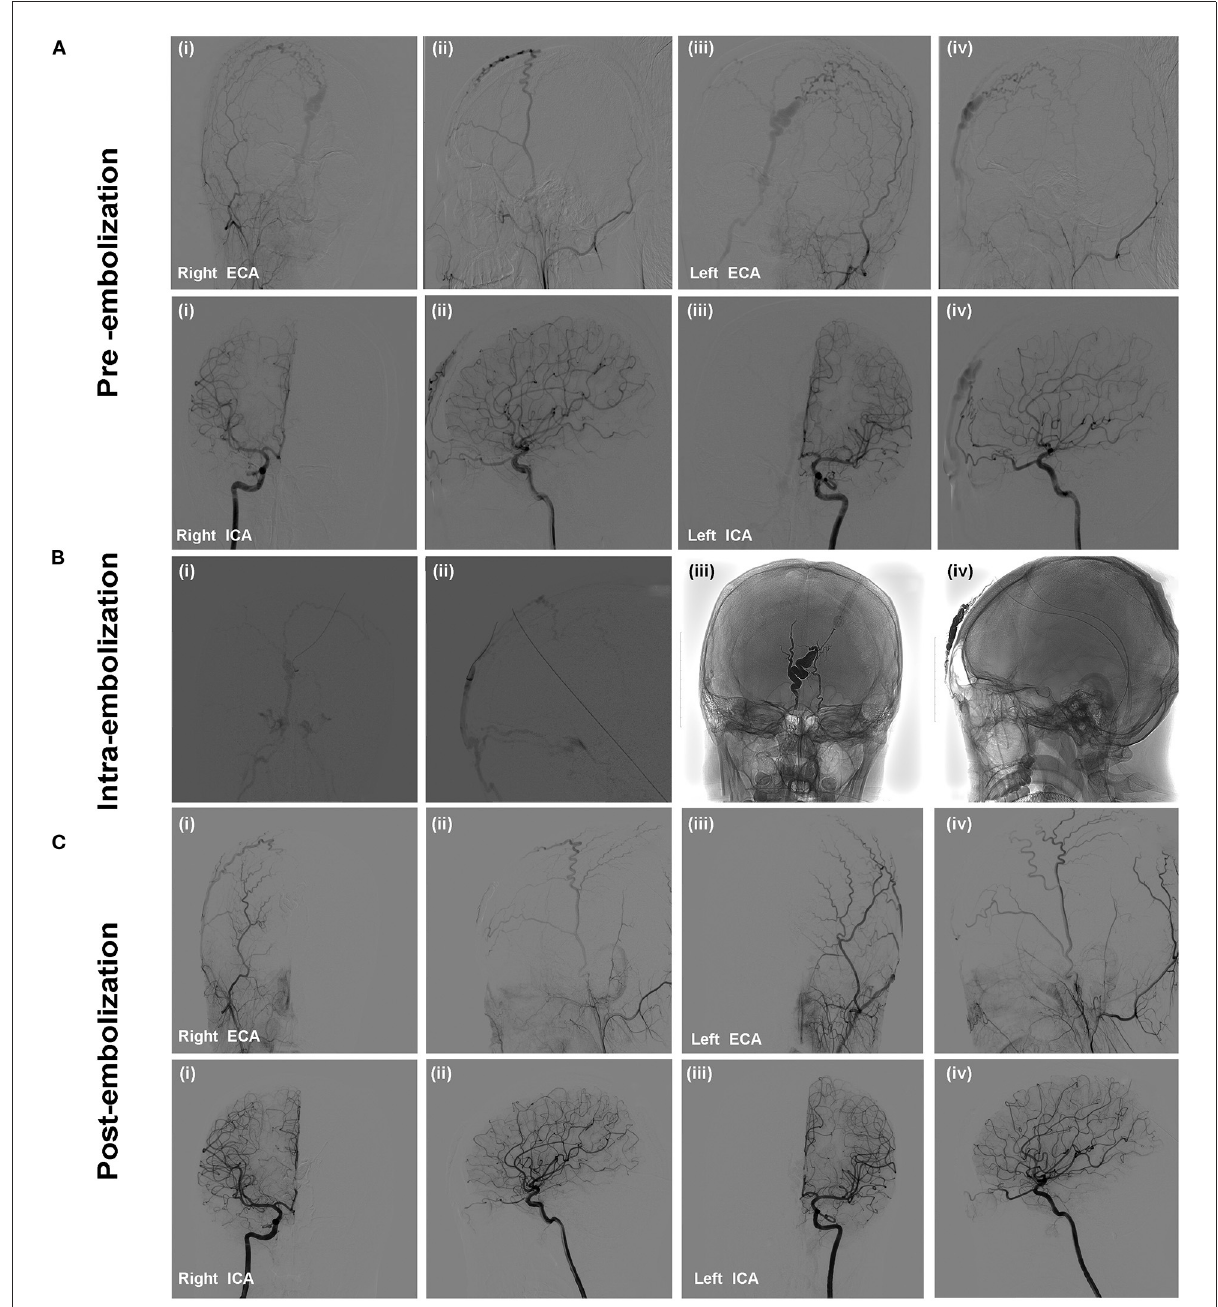
FIGURE1 The patient presented with a pulsatile forehead mass without specific medical history. Selective cerebral DSA confirmed the presence of scalp AVM. Angiographic images showed that the feeding arteries of the lesion were bilateral frontal branches of STAs and ophthalmic arteries (A) . Onyx-18 liquid embolic material was injected to embolize the draining veins, fistulous connection, and feeding arteries. (B) Angiography was performed via microcatheter (i,ii); Penetration and solidification of Onyx after embolization (iii,iv); (C) Post-embolization angiography demonstrated the scalp AVM was occluded completely without non-targeted vessels embolization.